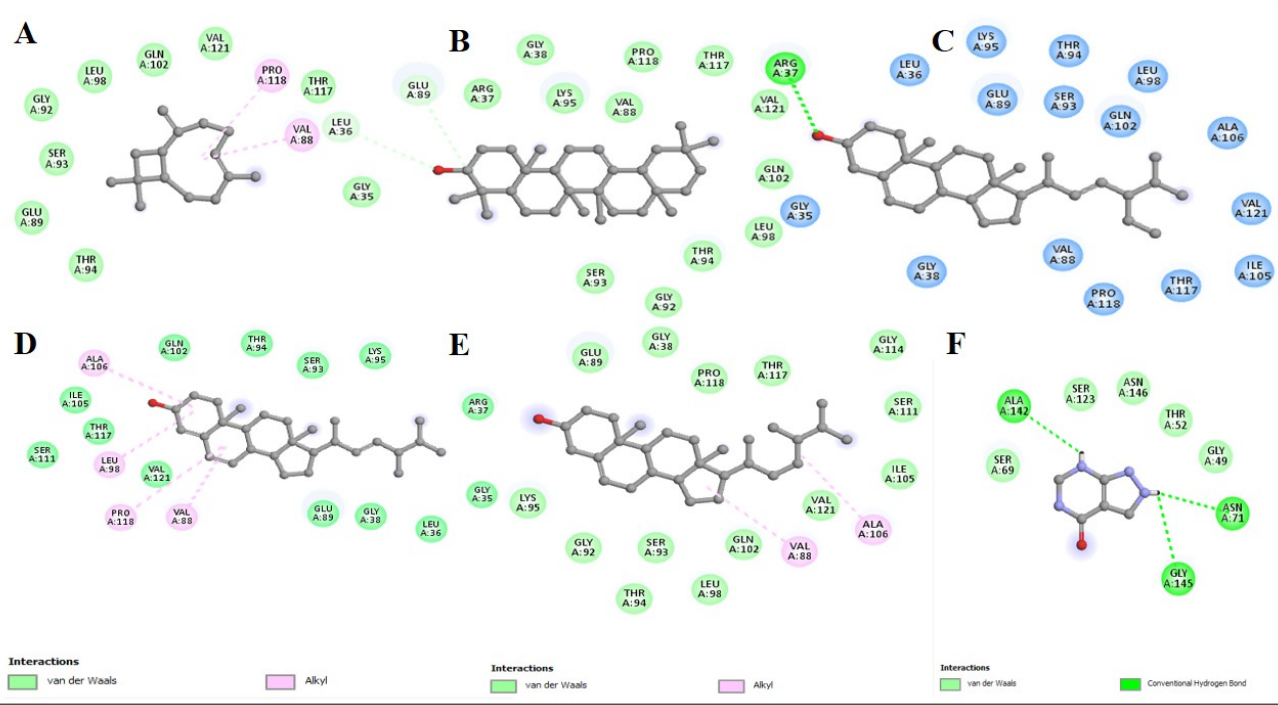
Figure 5. Two-dimensional structured binding interactions of Caryophyllene ( A ), β -Amyrin ( B ), Stigmasterol ( C ), Ergosta-4,6,22-trien-3-ol ( D ), Campesterol ( E ), and Allopurinol (standard) ( F ) with xanthine oxidase enzyme.